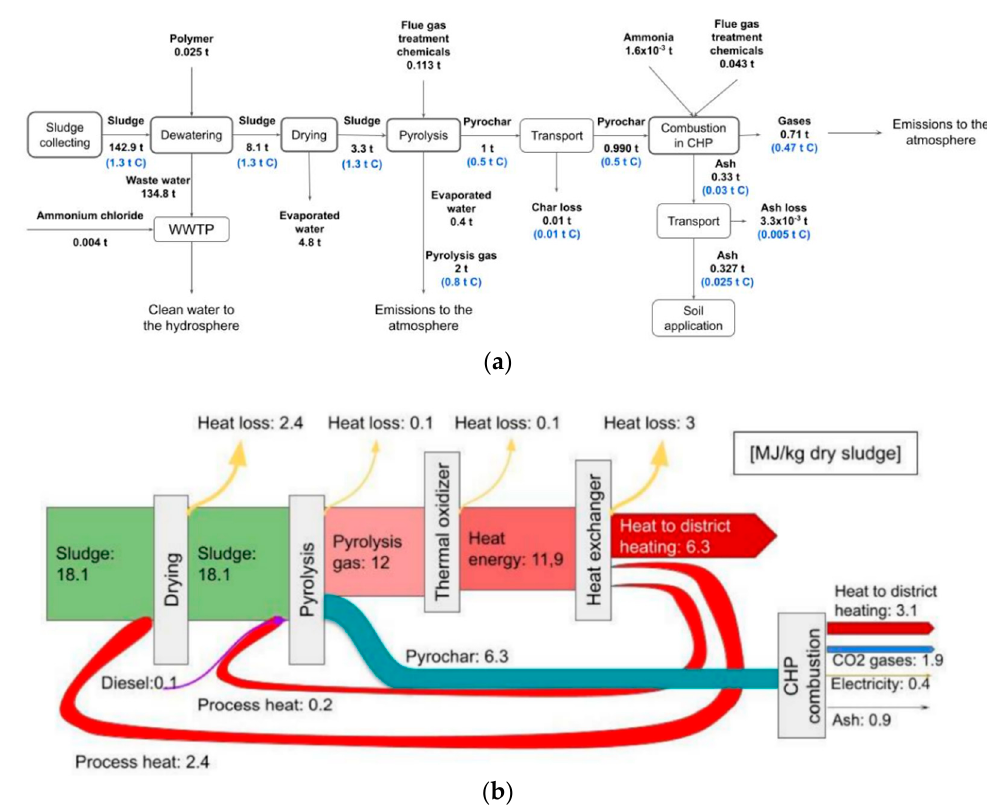
Figure 2. ( a ) Material and carbon flows in Pyrochar Scenario, with 2.8 t dry sludge as FU, including process value (in black) and substance flow of carbon (in blue). ( b ) Energy flows (MJ/FU) in Pyrochar Scenario with using pyrolysis gases in drying and pyrolysis processes.